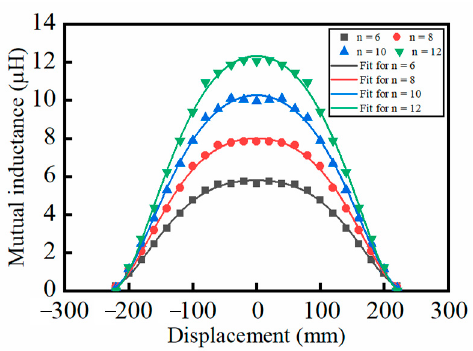
Figure 4. Coupling of coils with different turns in different positions.